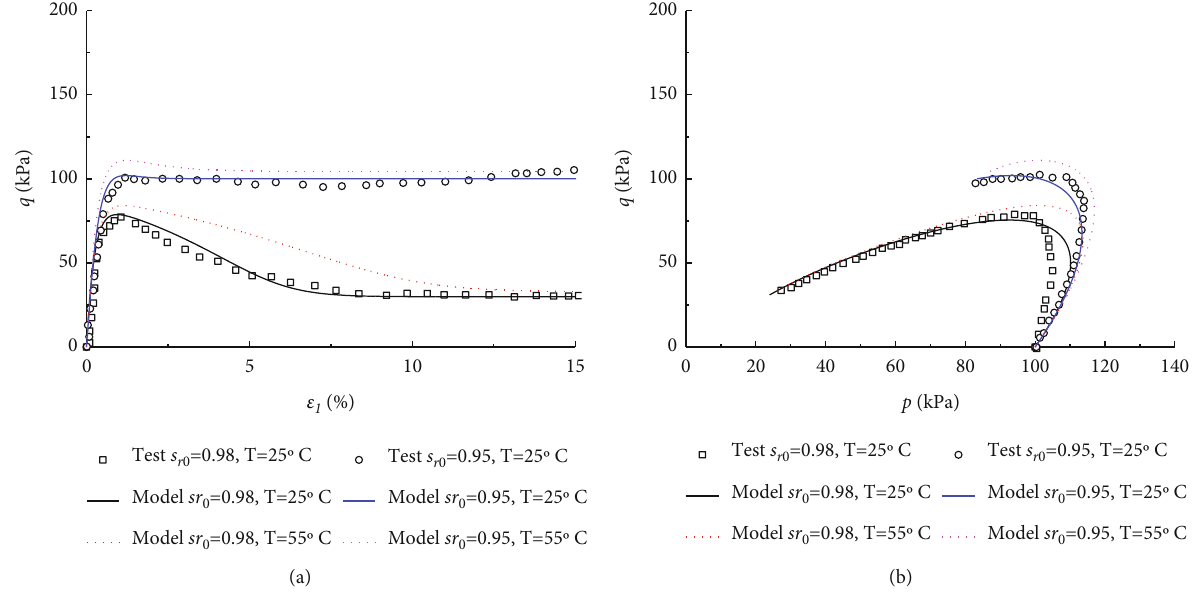
Figure 6: Simulation of undrained shear properties of loose gassy sand with di ff erent initial saturation at di ff erent temperatures: (a) stress- strain relationships; (b) e ff ective stress path (test data after He and Chu